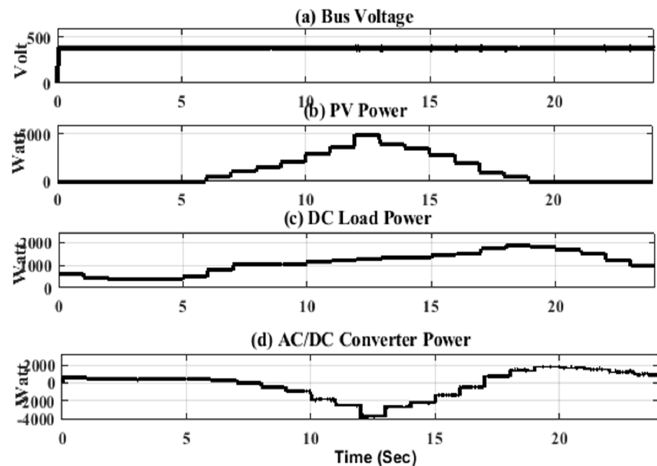
Figure 7. Simulation results: ( a ) direct current (DC) link bus voltage (V), ( b ) output power of photovoltaic (PV) system (Watt), ( c ) local DC load power (Watt), and ( d ) the grid tie converter power (Watt).